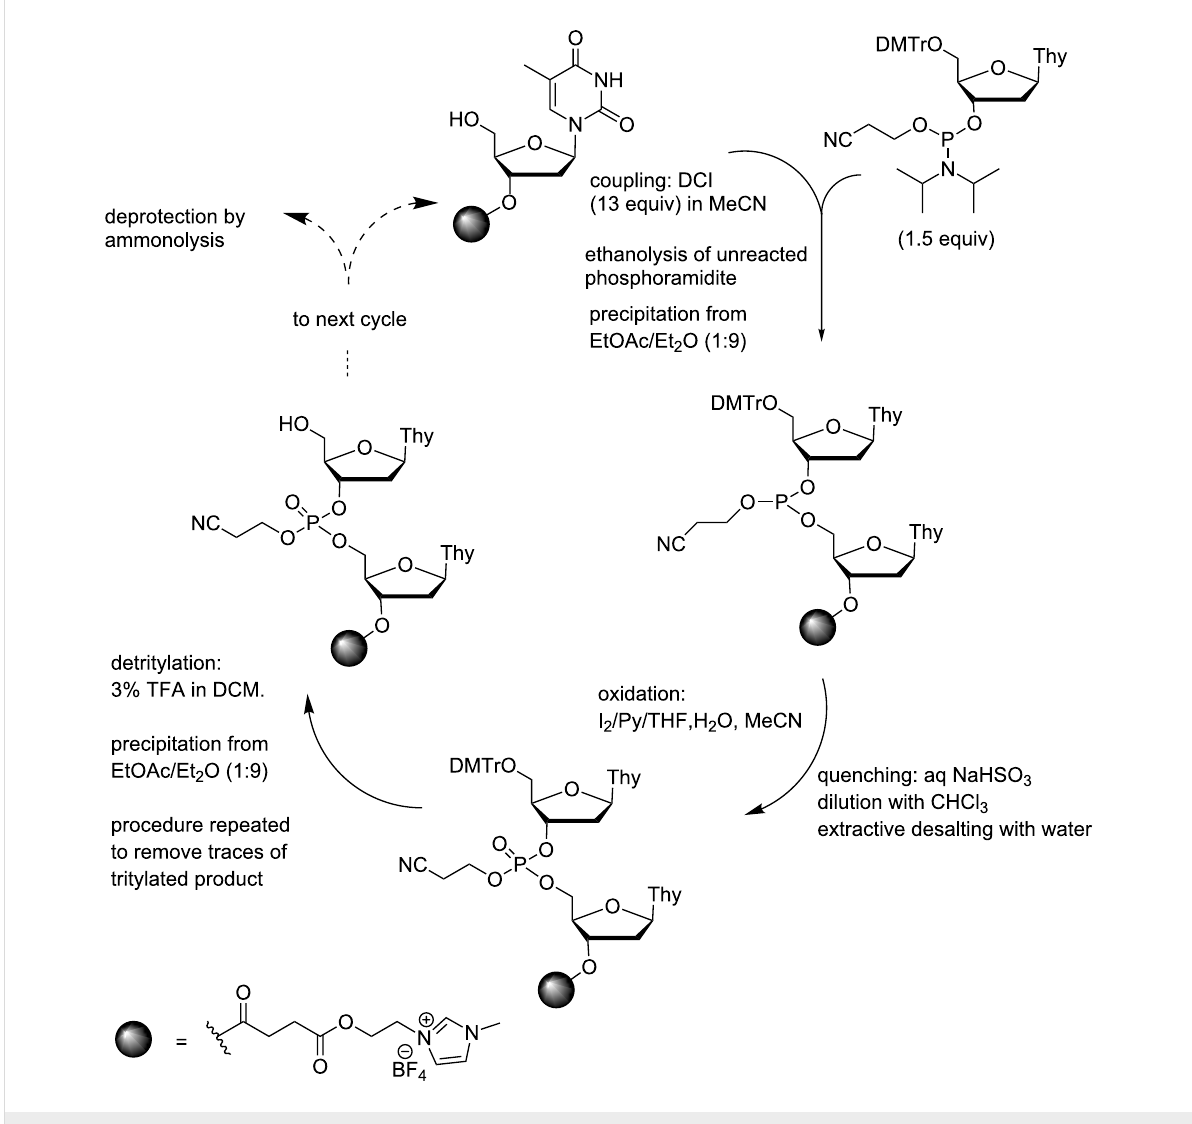
Scheme 7: Synthesis of ODNs by a combination of extractive and precipitative strategy